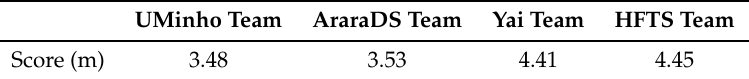
Table 3. Competition Results—Third Quartile of the positioning error with penalties (in meters) on the 505 test